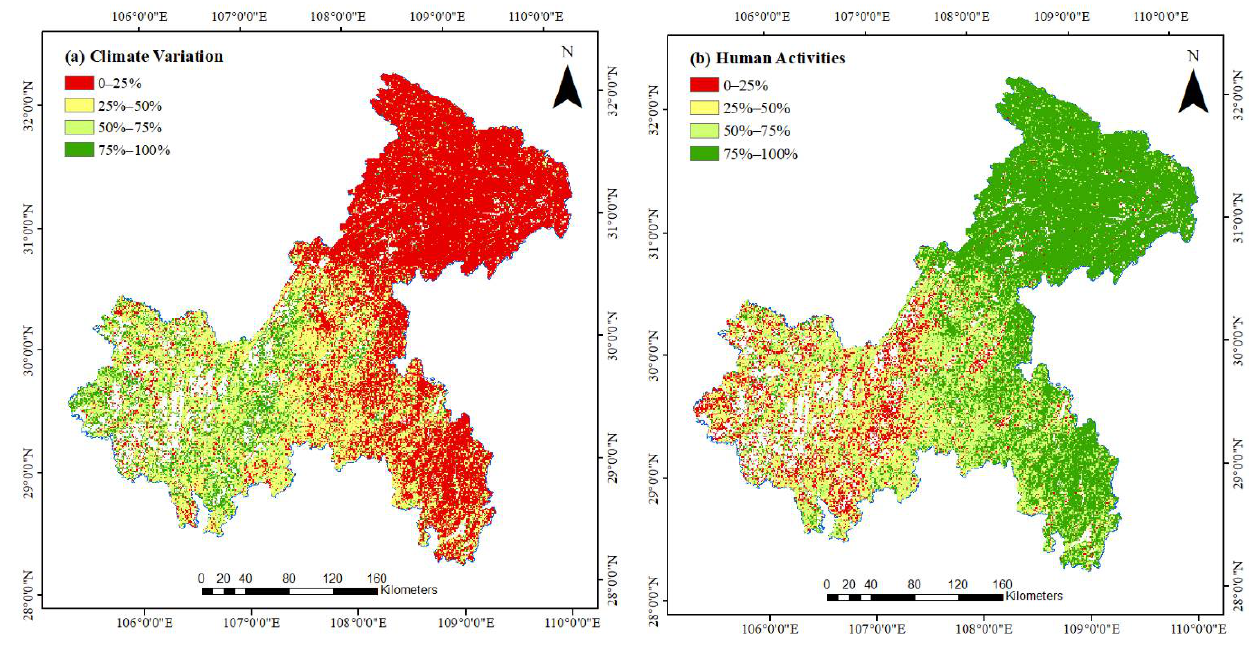
Figure 10. Relative contribution of ( a ) climate change and ( b ) human activities to areas of increased vegetation